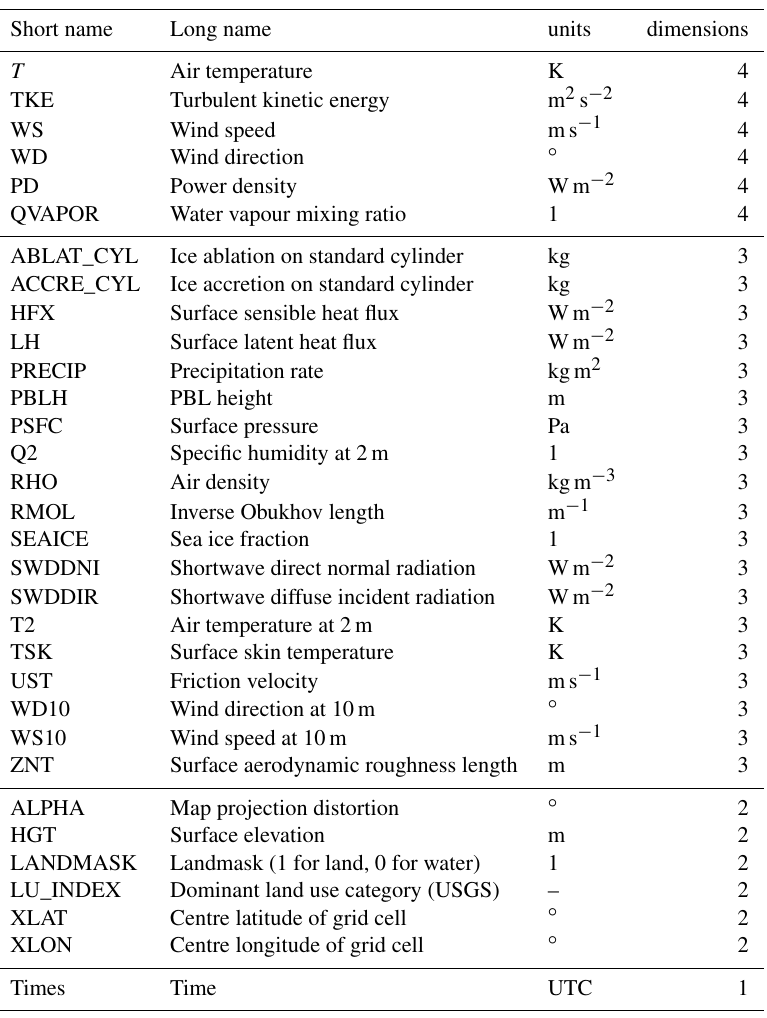
Table A1. Overview of the final wind atlas parameters that were stored in netCDF files following CF-1.6 conventions. The four-dimensional variables are given at 50, 75, 100, 150, 200, 250, and 500ma.g.l. All three- and four-dimensional variables are provided at 30min time intervals. A post-processing script (written in python) that calculates these parameters is given in: